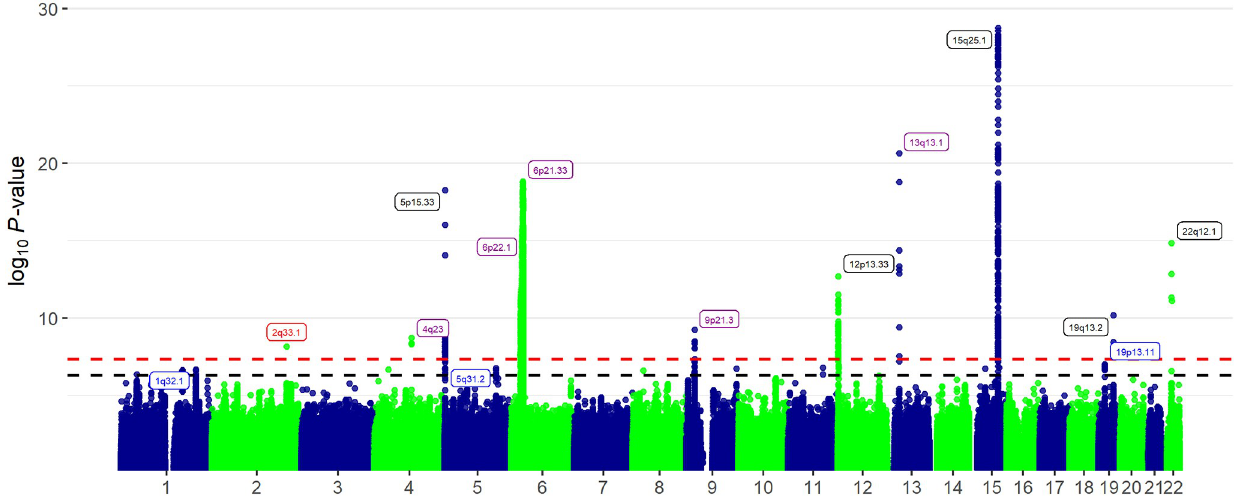
Fig 1. Manhattan plot of aerodigestive SqCC genome-wide association fixed-effects meta-analysis results. The y-axis corresponds to − log10 P -values, and x-axis to genomic positions. Horizontal red dashed line ( P = 5x10 − 8 ) and black dashed line ( P = 5x10 − 7 ). Highlighted in red are the newly identified pleotropic aerodigestive SqCC loci ( P < 5x10 -8 ), in blue new loci at P < 5x10 -7 and in purple previously identified pleotropic loci (at least 2 cancer sites). Loci labeled in black are loci that reached P < 5x10 -7 but were not pleiotropic associated only in single-cancer